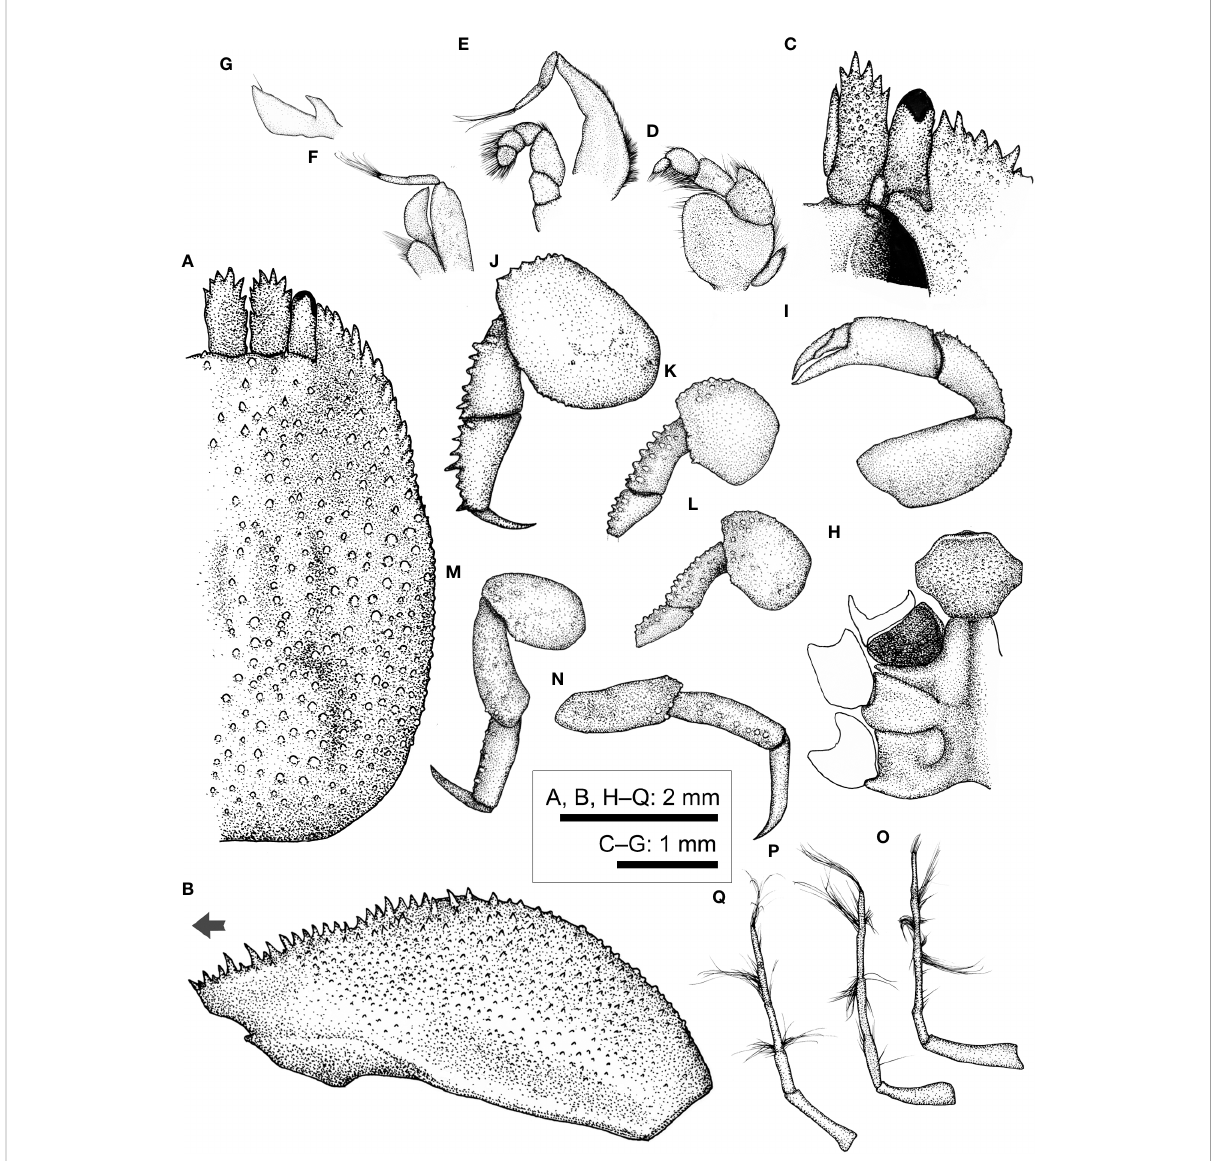
FIGURE 11 Lithoscaptus cf. doughnut , female (CEL-Hapa-006). (A) carapace, dorsal view; (B) carapace, lateral view; (C) anterior view of carapace, ventral view; (D) left Mxp3; (E) left Mxp2; (F) left Mxp1; (G) left Mxl 1; (H) thoracic sternites; (I) left P1; (J – M) left P2 to P5, dorsal view; (N) left P5, lateral view; (O – Q) plp1 to plp3, lateral view. Arrow in (B) indicates the anterior